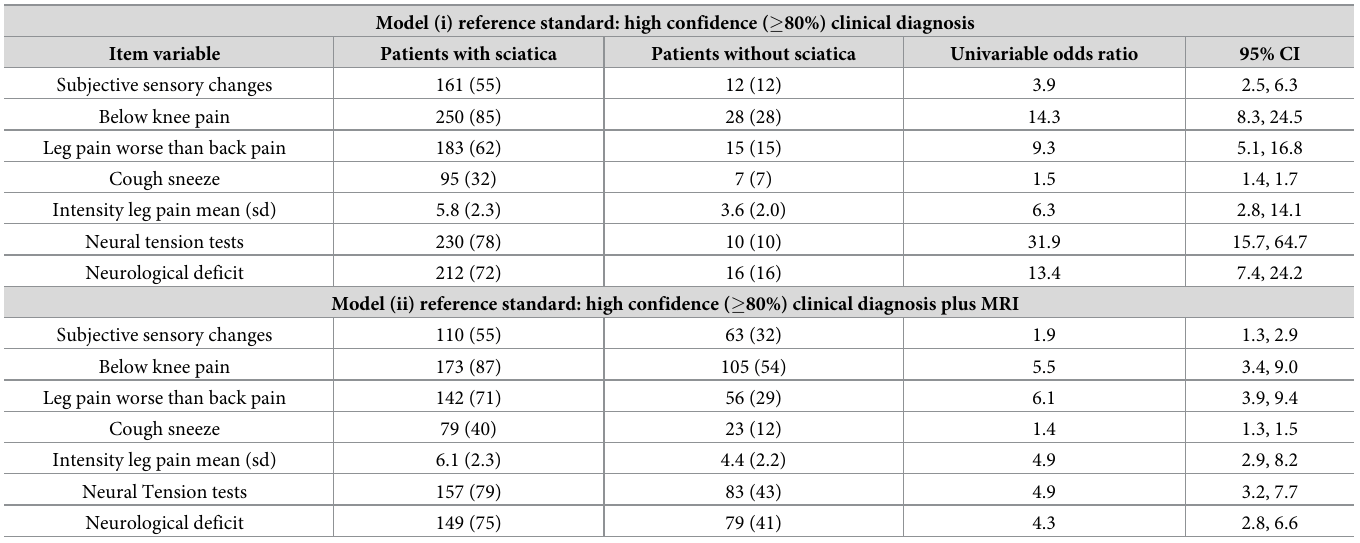
Table 2. Univariable associations between predictor variables and outcomes.